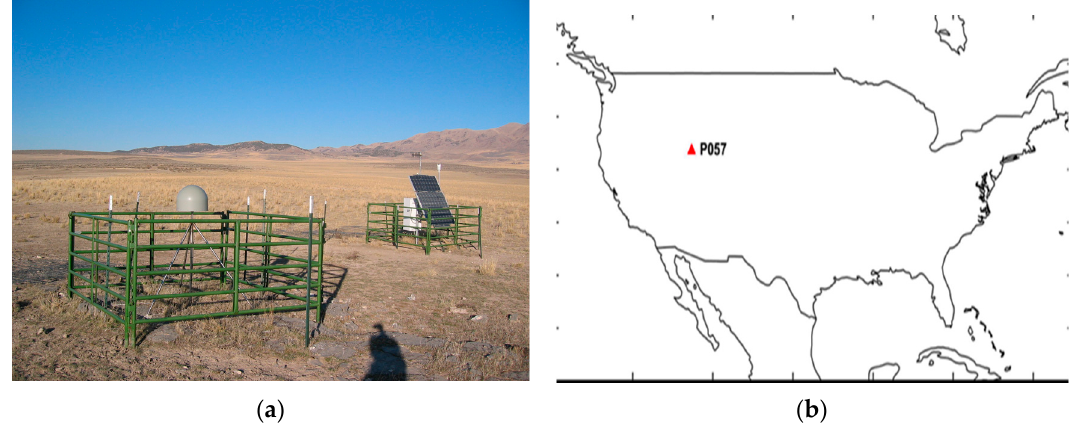
Figure 2. P057 site ( a ) overview of the site; ( b ) location of the site.